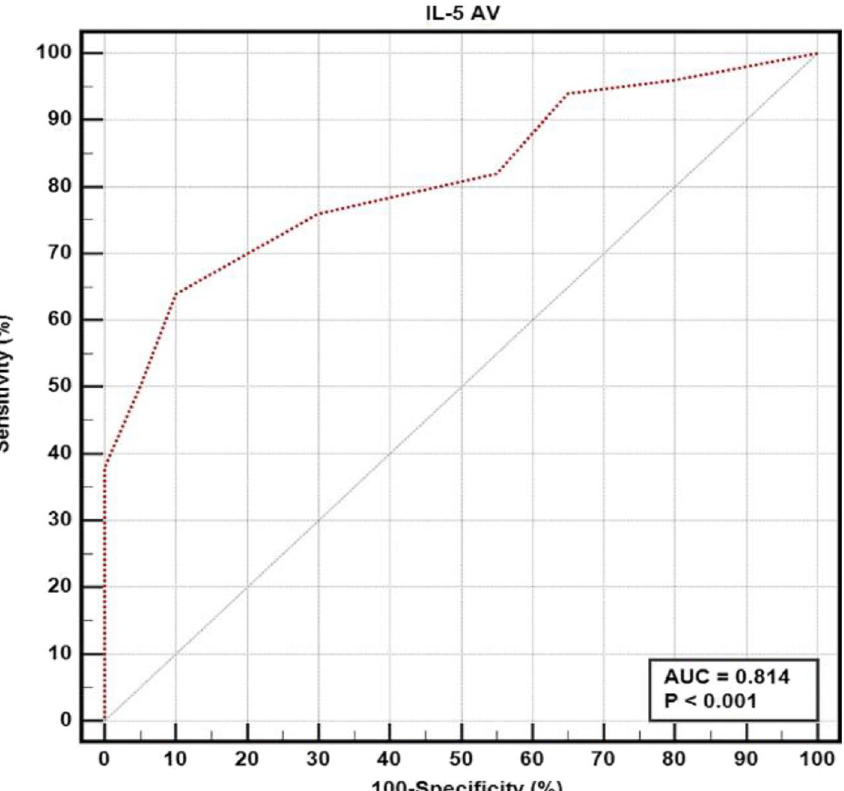
Fig. 5 Response-operating characteristic (ROC) curve analysis for discrimination between cases and controls using IL-5 AV. IL-5 AV has good discriminative value. Area under the ROC curve (AUC) specificity 90%, J-index .54) = =